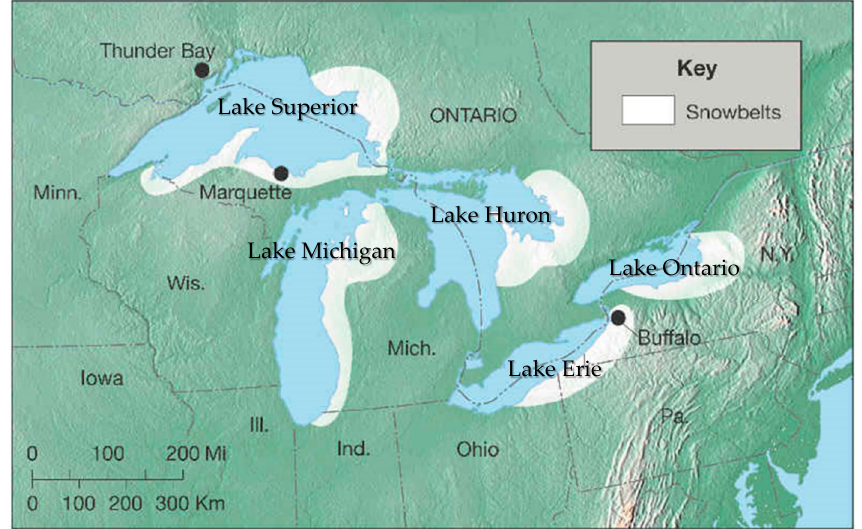
Figure 1. North American Great Lakes Snowbelt region highlighting areas that are affected by LES every winter. Image taken from Dept. of Geography at Hunter College, City University of New York.